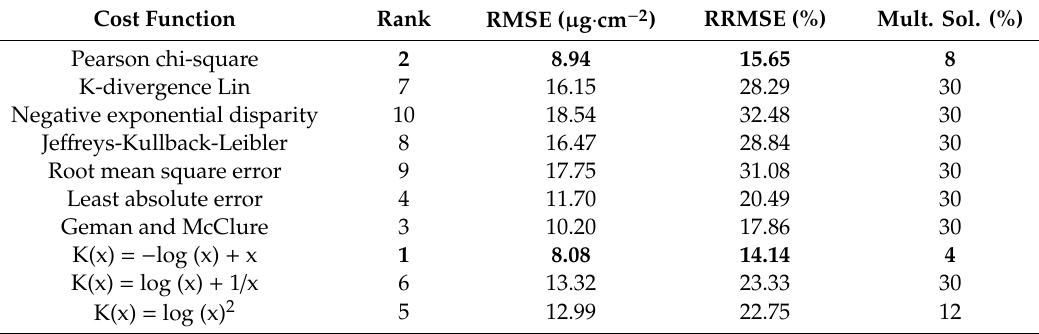
Table 7. Ground validation results of LUT-based inversion with Landsat-8 OLI data.